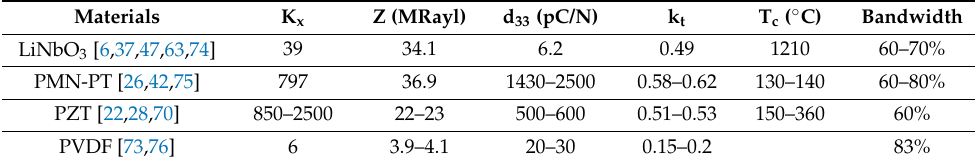
Table 4. The acoustic and piezoelectric properties of common piezoelectric materials. K S : clamped rel- ative dielectric constant. Z: acoustic impendence. d 33 : piezoelectric constant. K t : electro–mechanical coupling coefficient. T C : Curie